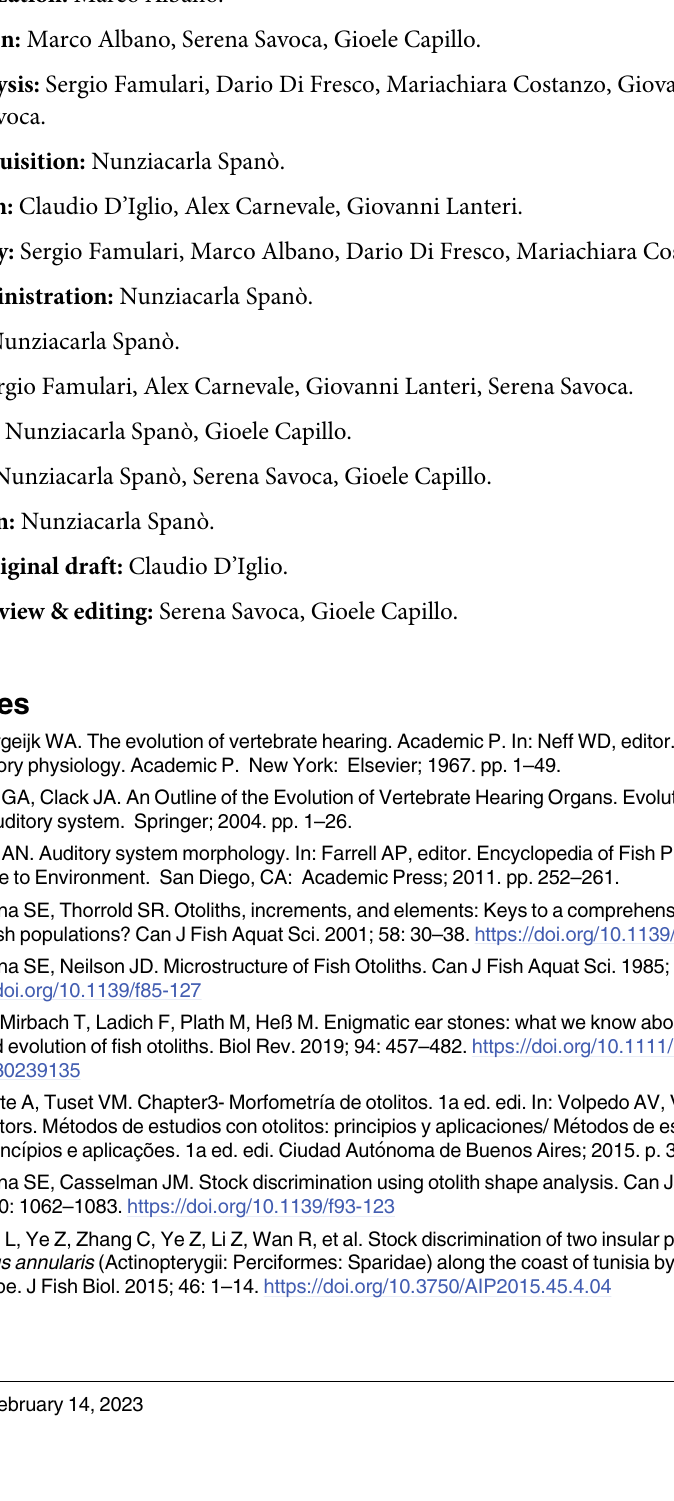
S2 Fig. Mean and standard deviation (sd) of Wavelet coefficients for all combined sagittae (a) and lapilli (b) and the proportion of variance among size classes (black line). The hori- zontal axis shows angle in degrees (˚) based on the polar coordinates of the mean otoliths shape plot. The centroid of the otolith is the center point of polar coordinates.